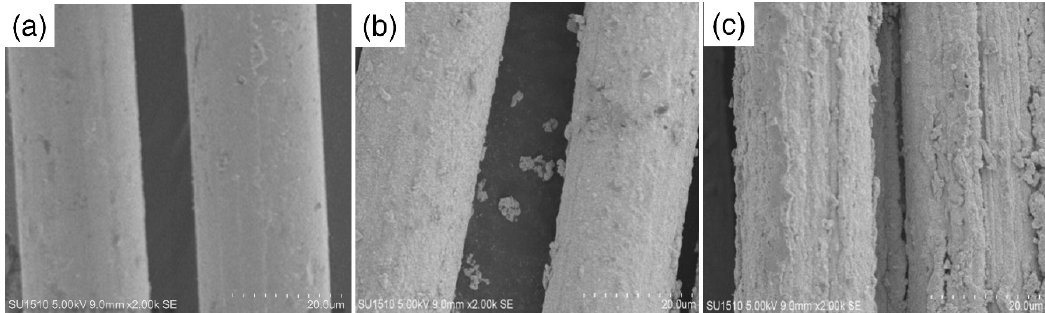
Figure 4. SEM images of polyester fibers for different electroplating time: ( a ) 0 min; ( b ) 4 min; ( c ) 8 min.